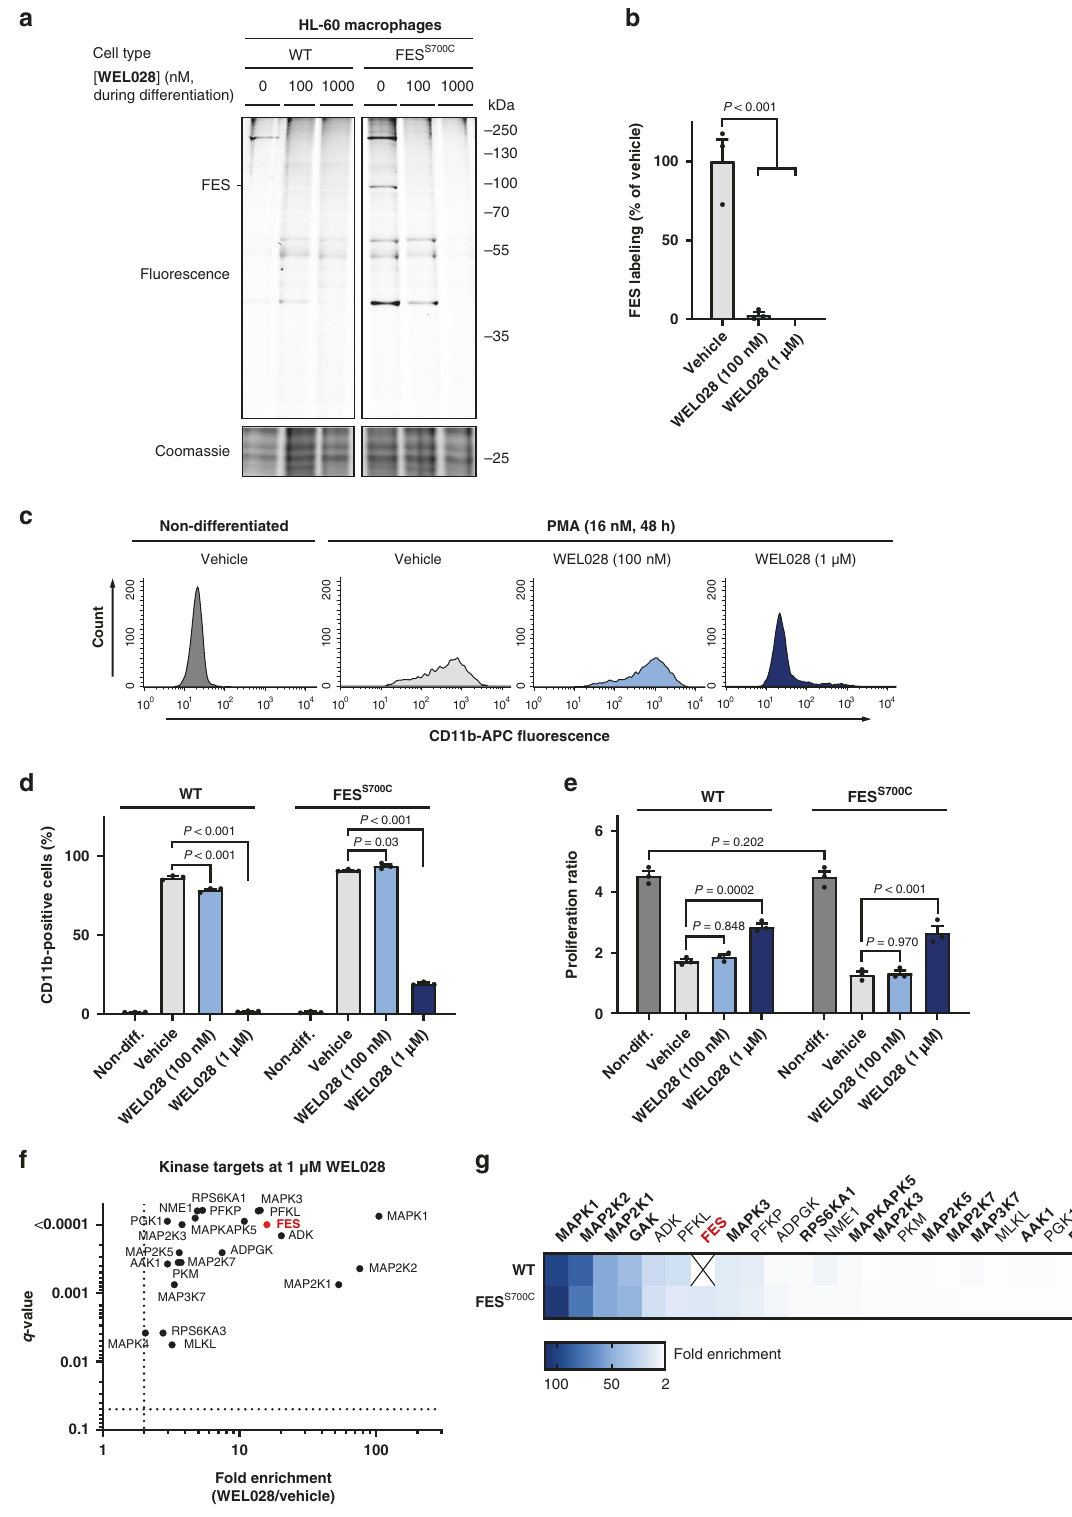
Quantitative label-free chemical proteomics was used to identify the off-targets of WEL028 at this high concentration. The WEL028-labeled proteome was conjugated to biotin-azide post-lysis, followed by streptavidin enrichment, on-bead protein digestion and peptide analysis using mass spectrometry. Sig- ni fi cantly enriched kinases in WEL028-treated samples compared to vehicle-treated samples were designated as targets (Fig. 6f-g).